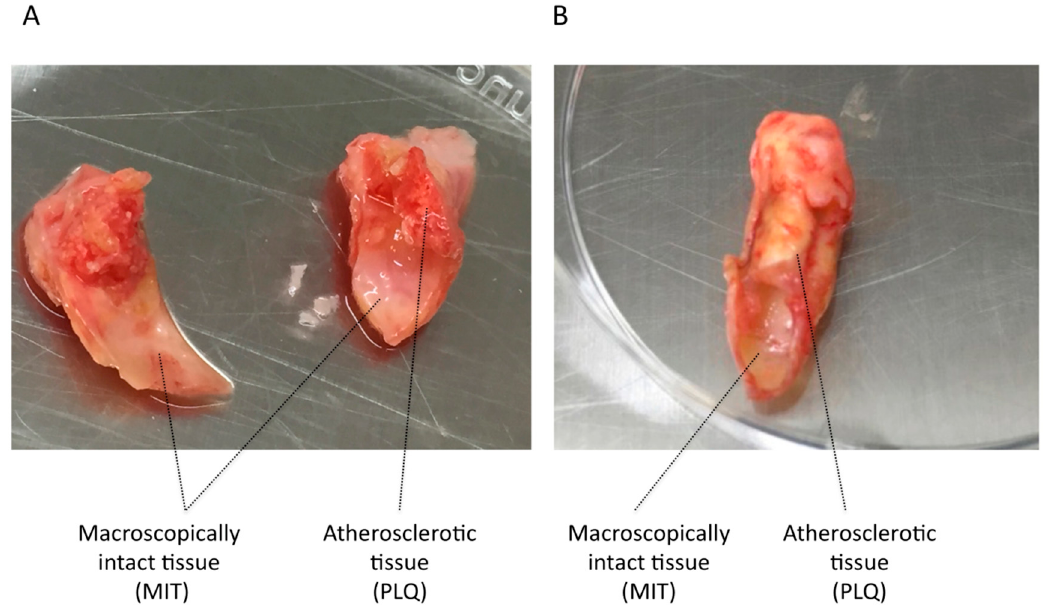
Figure 1. Illustrative photos of carotid endarterectomy specimens. Macroscopically intact tissue and atherosclerotic tissue is visualized on sample from patient 1 ( A ) and patient 2 ( B ).